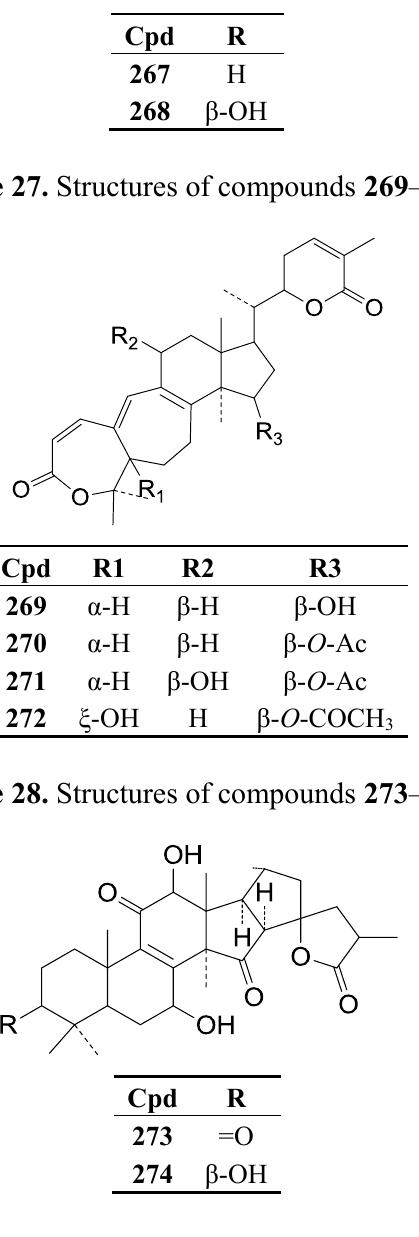
Figure 29. Structures of compounds 275 – 276